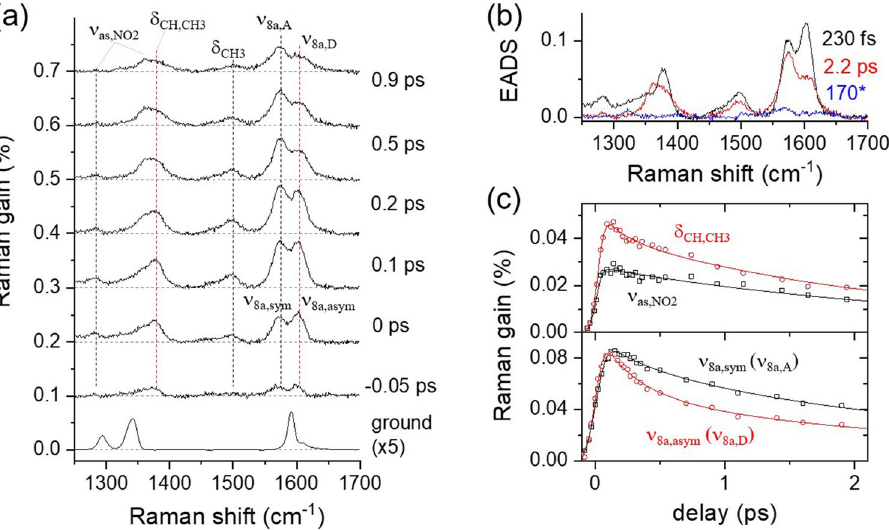
Figure 3. Femtosecond stimulated Raman spectroscopy (FSRS) of 4-dimethylamino-4 ′ -nitrobiphenyl (DNBP) with 403 nm excitation; ( a ) time-resolved Raman spectra compared to the ground spectrum, ( b ) evolution- associated difference spectra (EADS) from the global analysis of excited state Raman spectra, ( c ) kinetic traces for the major vibrational modes of ν as,NO2 (1361 cm −1 ) and δ CH,CH3 (1378 cm −1 ), ν 8a,sym (1574 cm −1 ), and ν 8a,asym (1602 cm −1 ) modes.